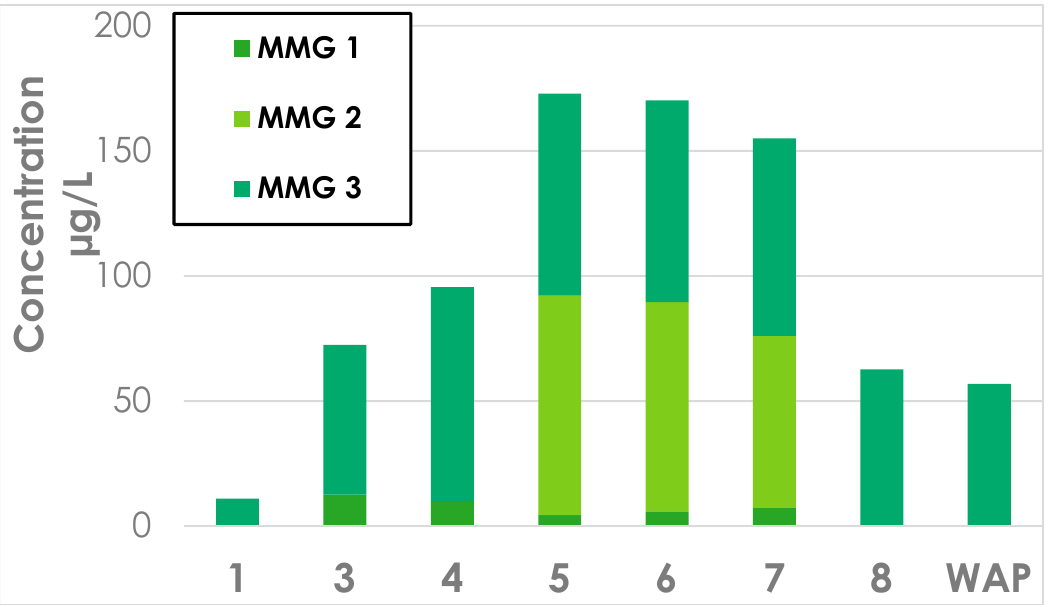
Figure A1. Evolution of MMG isomers during Syrah fermentation.